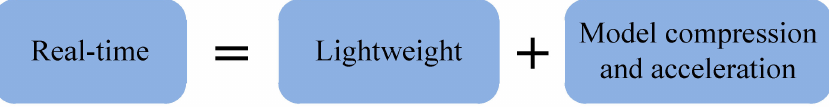
Figure 21. Lightweight CNN, model compression and acceleration are two ways to implement real-time recognition.